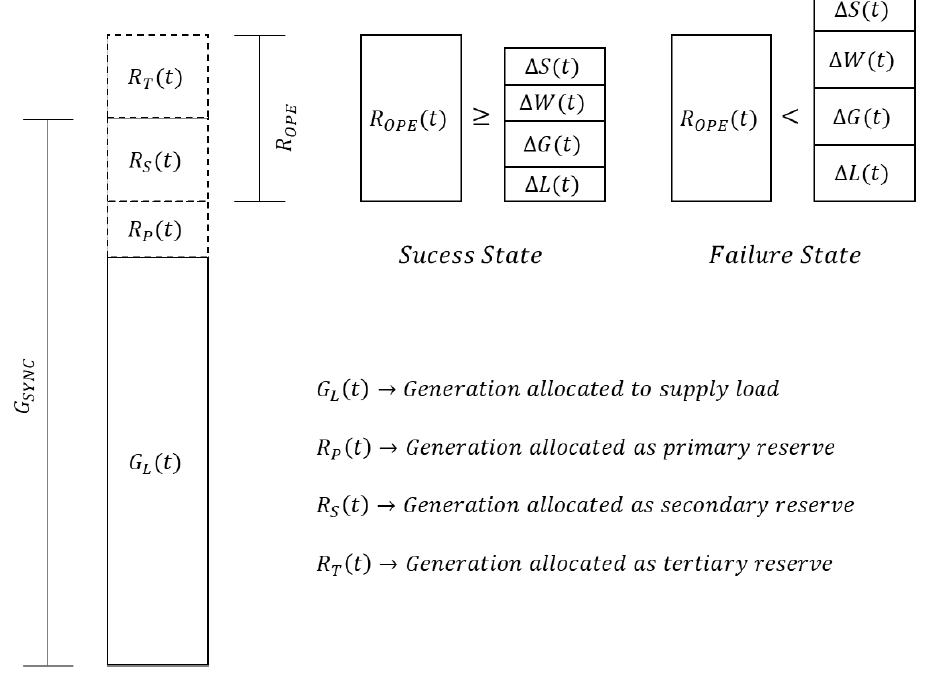
Figure 1. Long-term operating reserve framework.